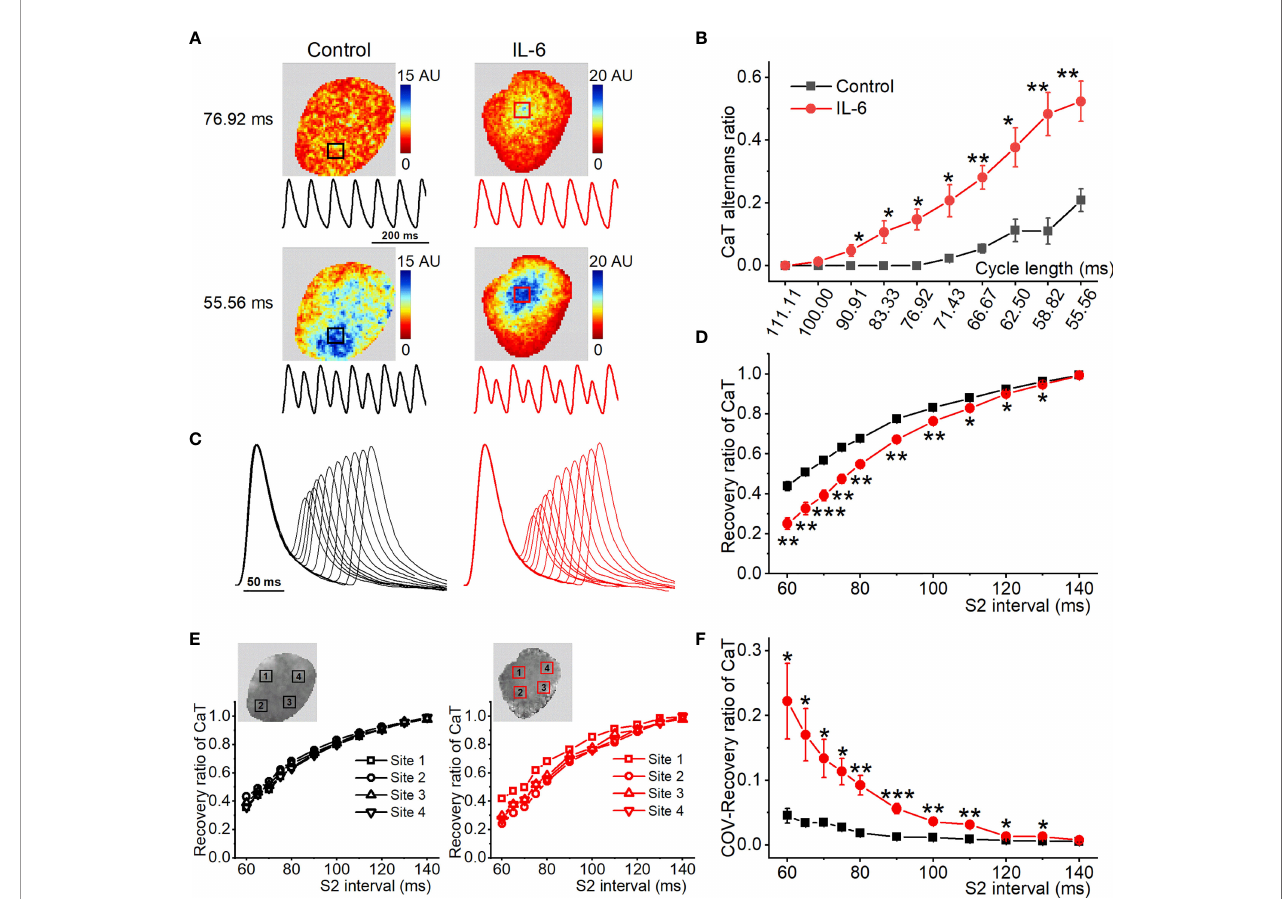
FIGURE 7 | Exogenous IL-6 administration increases the onset of atrial CaT alternans. (A) Maps of atrial CaT alternans (spectral magnitude) in the control and IL-6 groups during progressive decreases in cycle length, along with corresponding example CaT traces from the location indicated with a box in the maps. (B) Quanti fi cation of CaT alternans for each pacing rate. (C) Superimposed CaT traces from the control and IL-6 groups at S2 intervals ranging from 140 to 60 ms. (D) Quanti fi cation of recovery ratio of CaT at each S2 interval. (E) The recovery ratio of CaT was plotted against the S2 interval at the 4 locations indicated with a box in the upper map from the 2 groups. (F) Quanti fi cation of COV of recovery ratio of CaT. Control, n = 5; IL-6, n = 6. *P < 0.05, **P < 0.01, ***P < 0.001 vs . Control determined by Student